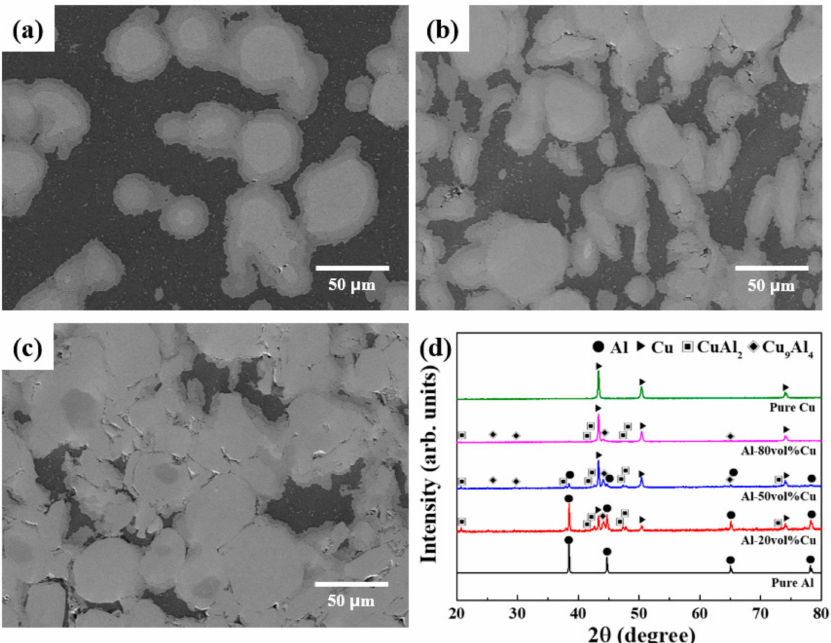
Figure 4. SEM micrographs of ( a ) Al–20Cu, ( b ) Al–50Cu, and ( c ) Al–80Cu composites, and ( d ) XRD patterns of Al–Cu